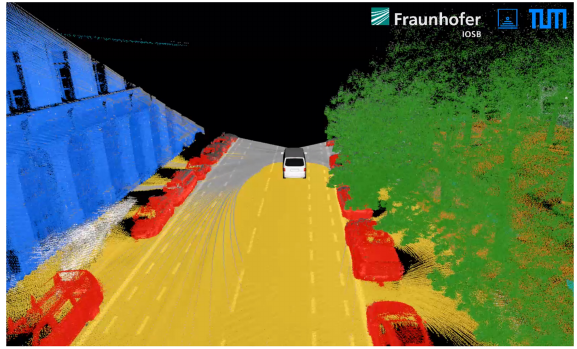
Figure 7. Labeled each scan of the MLS